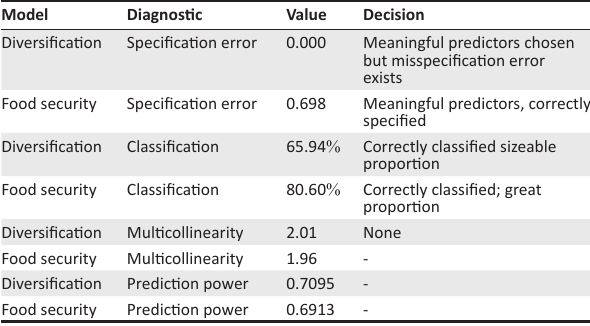
TABLE 9: Diagnostic tests.